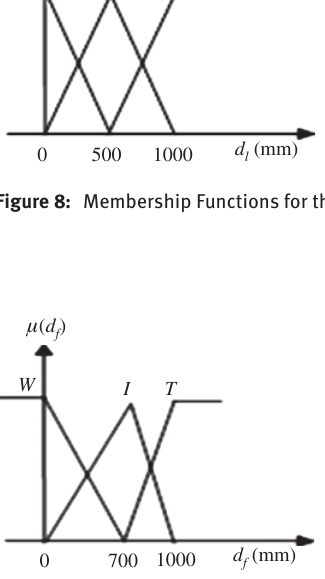
Figure 9: Membership Functions for the Front